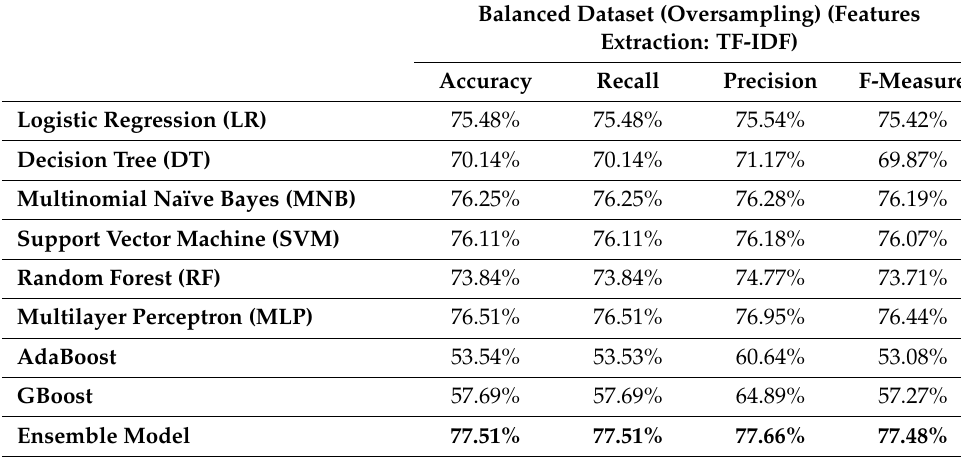
Table 8. Classification results for sentiment analysis of balanced dataset